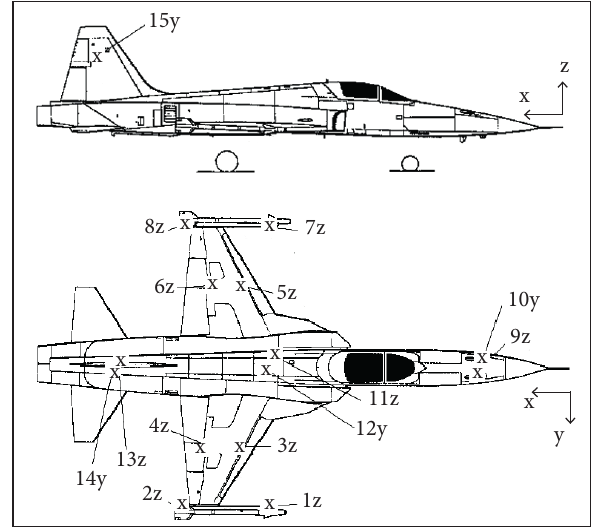
Figure 2. Accelerometers positioning in the